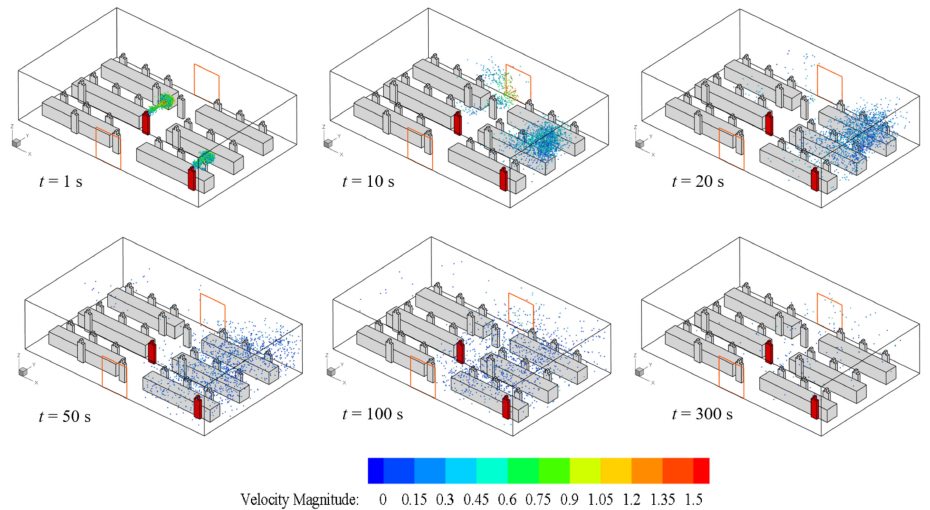
Figure 6. Distribution of aerosols in case 2 (front and back doors are